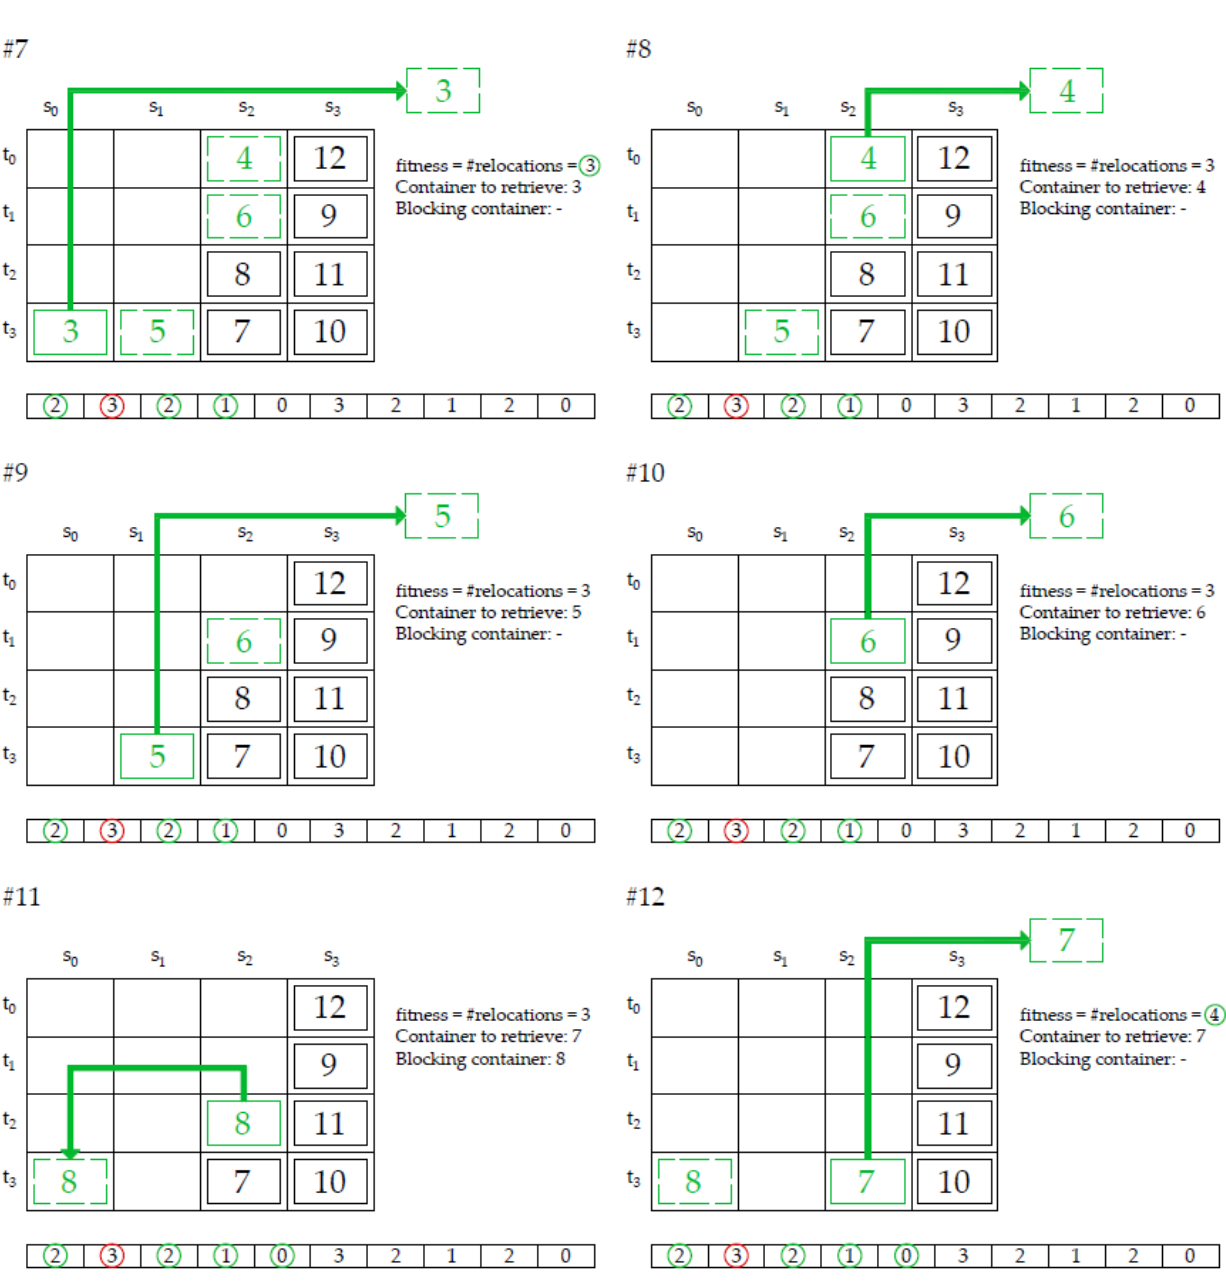
Figure 8. A complete fitness function calculation (2).